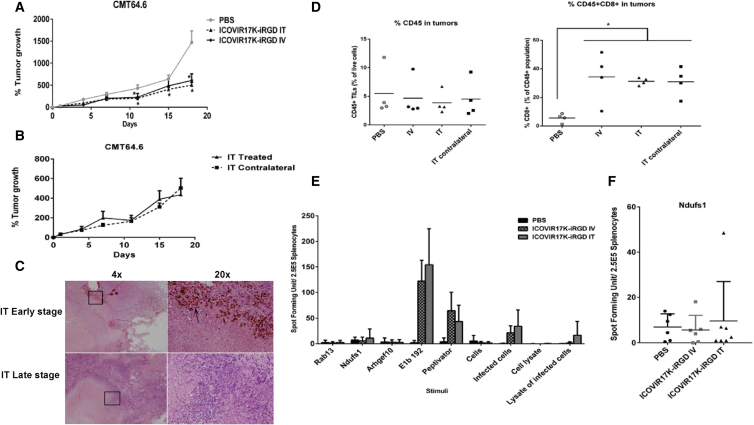
Anti-tumor Efficacy of Systemic or i.t. Administration of ICOVIR17K-iRGD in Immunocompetent MiceC57BL/6 mice bearing CMT64.6 murine lung carcinoma subcutaneous tumors were systemically treated with a single dose of PBS or 3 × 1010/mouse of ICOVIR17K-iRGD. (A) The percentage of tumor growth (mean ± SEM) at the indicated days is plotted (n = 11–12). Significance (*p < 0.05) by two-tailed unpaired Student’s t test compared with the PBS group. (B) Comparison of injected and non-injected contralateral tumors of the i.t. mice group. Percentage of tumor growth (mean ± SEM) at the indicated days is plotted (n = 5–6). (C) Immunohistochemical staining with E1A antibody of representative i.t. injected tumors at day 3 or at day 18 post-injection. (D) Levels of CD45 and CD45/CD8 cells in tumors from mice treated i.v. or i.t. (injected and non-injected contralateral tumors). Tumors were mechanically disaggregated and incubated for 30 min at 37°C in RPMI supplemented with collagenase. Single-cell suspensions were prepared, and then cells were stained for viability with Live/Dead fixable stain followed by flow cytometry analysis. (E) Evaluation of immune responses by IFN-γ-ELISpot assay. Splenocytes were harvested and used for analysis of T cell responses 18 days post-treatment (late stage). Three minimal epitopes from CMT64.6 sequencing were synthesized as minimal peptides to detect neoepitope-specific responses. E1b192 peptide and PepTivator (a pool of hexon peptides) were used to detect the immune response against adenovirus. The response to infected and non-infected cells (as whole cells or lysates) was also used to measure the response to the virus (infected conditions) relative to the response to the tumor (non-infected conditions). The graph shows representative results from 18 mice (n = 6 per group). (F) The response against the epitope Ndufs1 by each tested mouse.